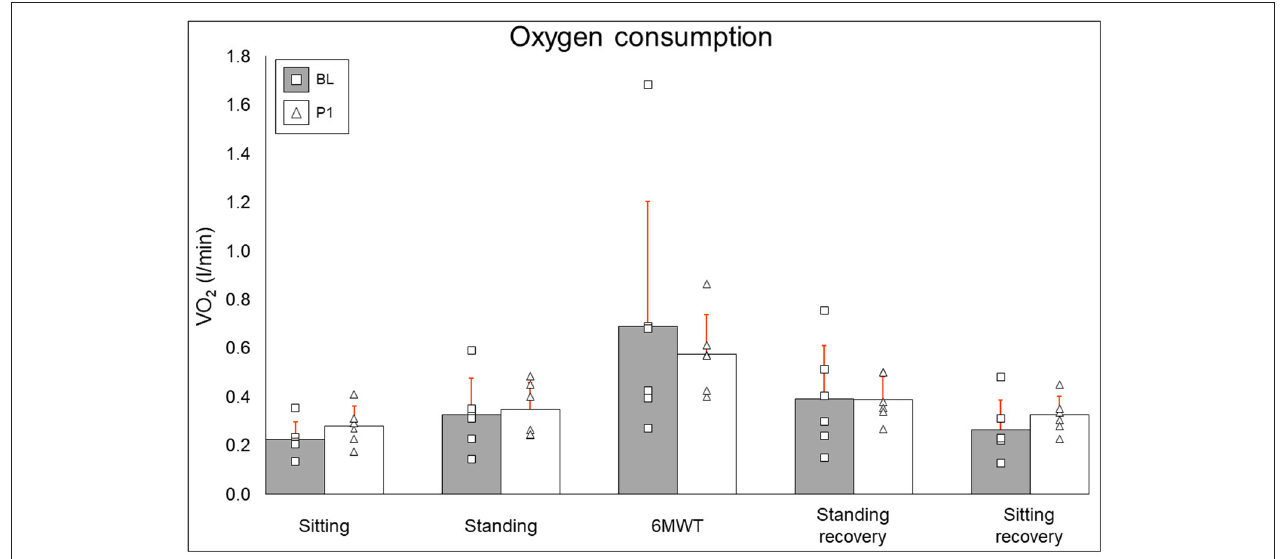
FIGURE 5 | Oxygen consumption results. Bars represent group averages (gray for baseline, white for post-intervention–red lines showing SD) with squares and triangles representing individual baseline and post-intervention values, respectively. l/min, liters per minute; BL, baseline; PI, post-intervention.